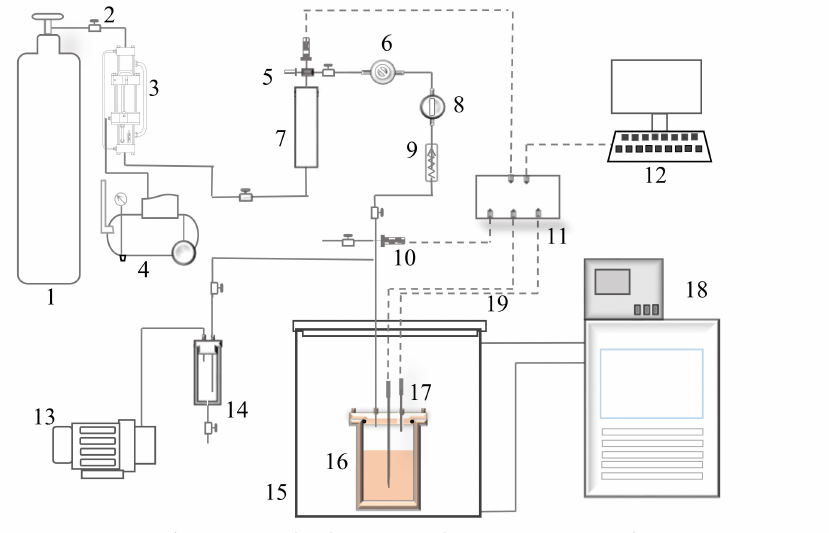
Figure 1. Schematic diagram of apparatus for measuring the stability conditions of methane